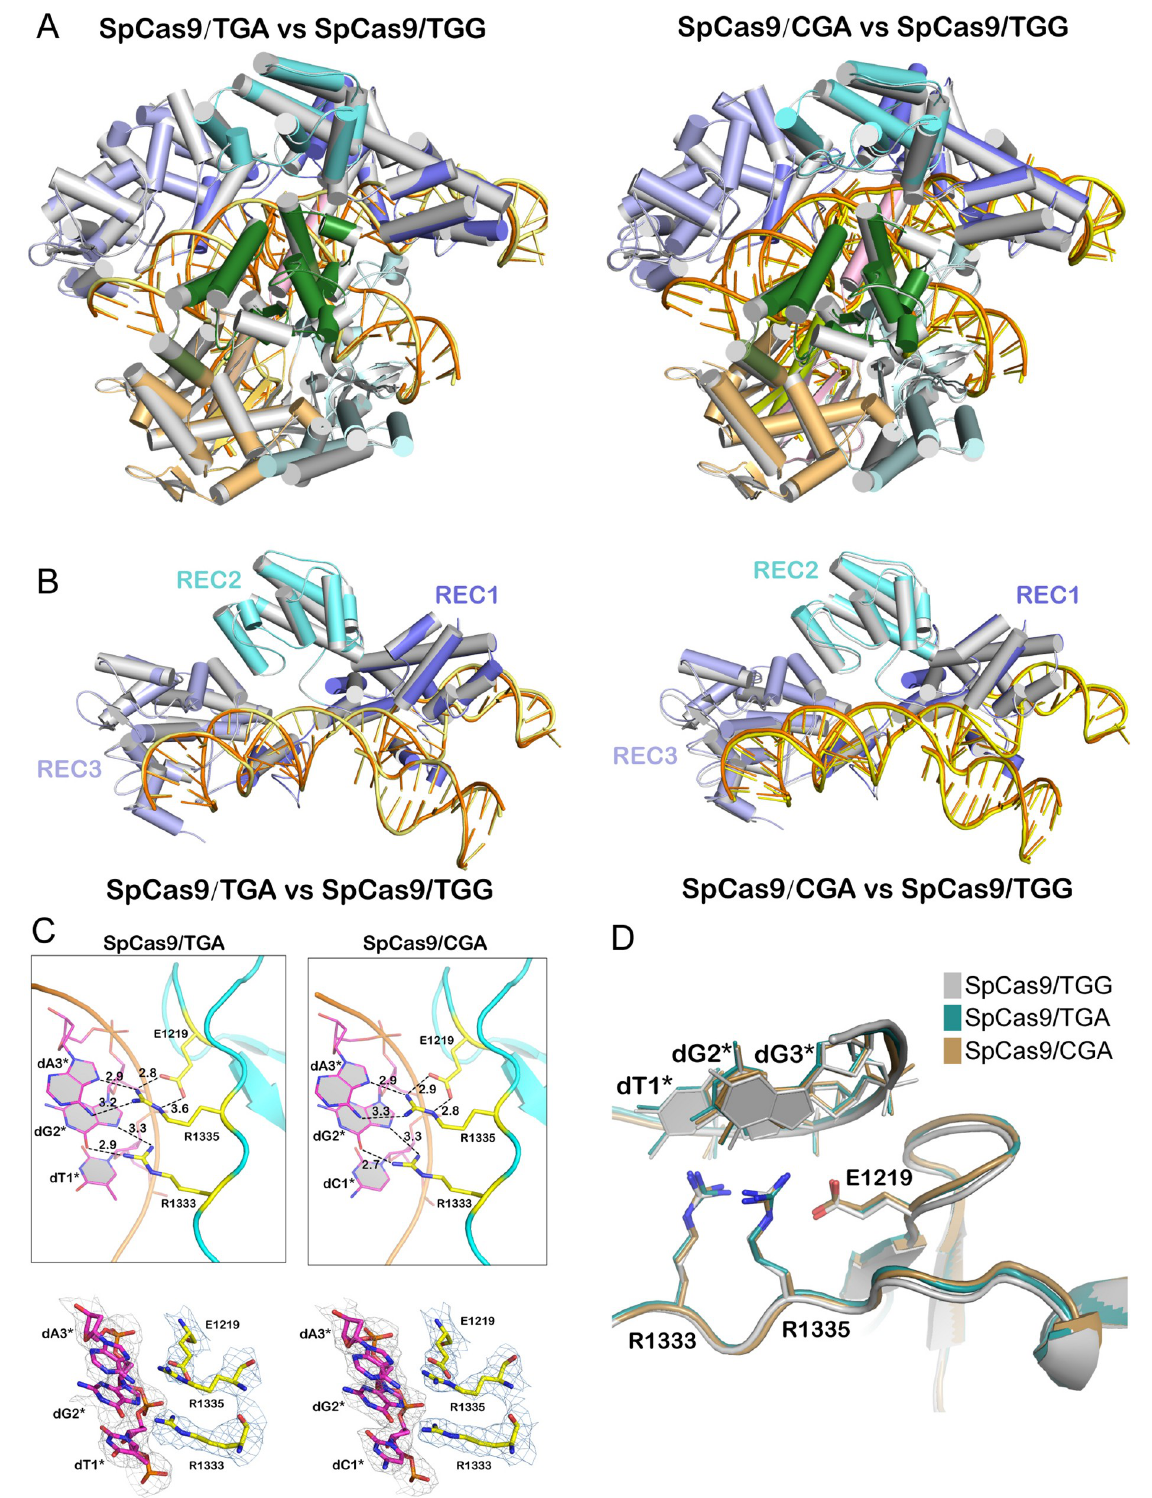
Fig 5. Structural comparison of SpCas9/TGA and SpCas9/CGA with SpCas9/TGG. (A) Superimposition of the overall structures of SpCas9/ TGA and SpCas9/CGA with SpCas9/TGG (PDB_ID: 4UN3). (B) Superimposition of the REC lobe of SpCas9/TGG with those of SpCas9 in complex with TGA (left) and CGA (right) PAMs. (C) Close-up view of the PAM recognition sites of TGA and CGA PAM-bound SpCas9.